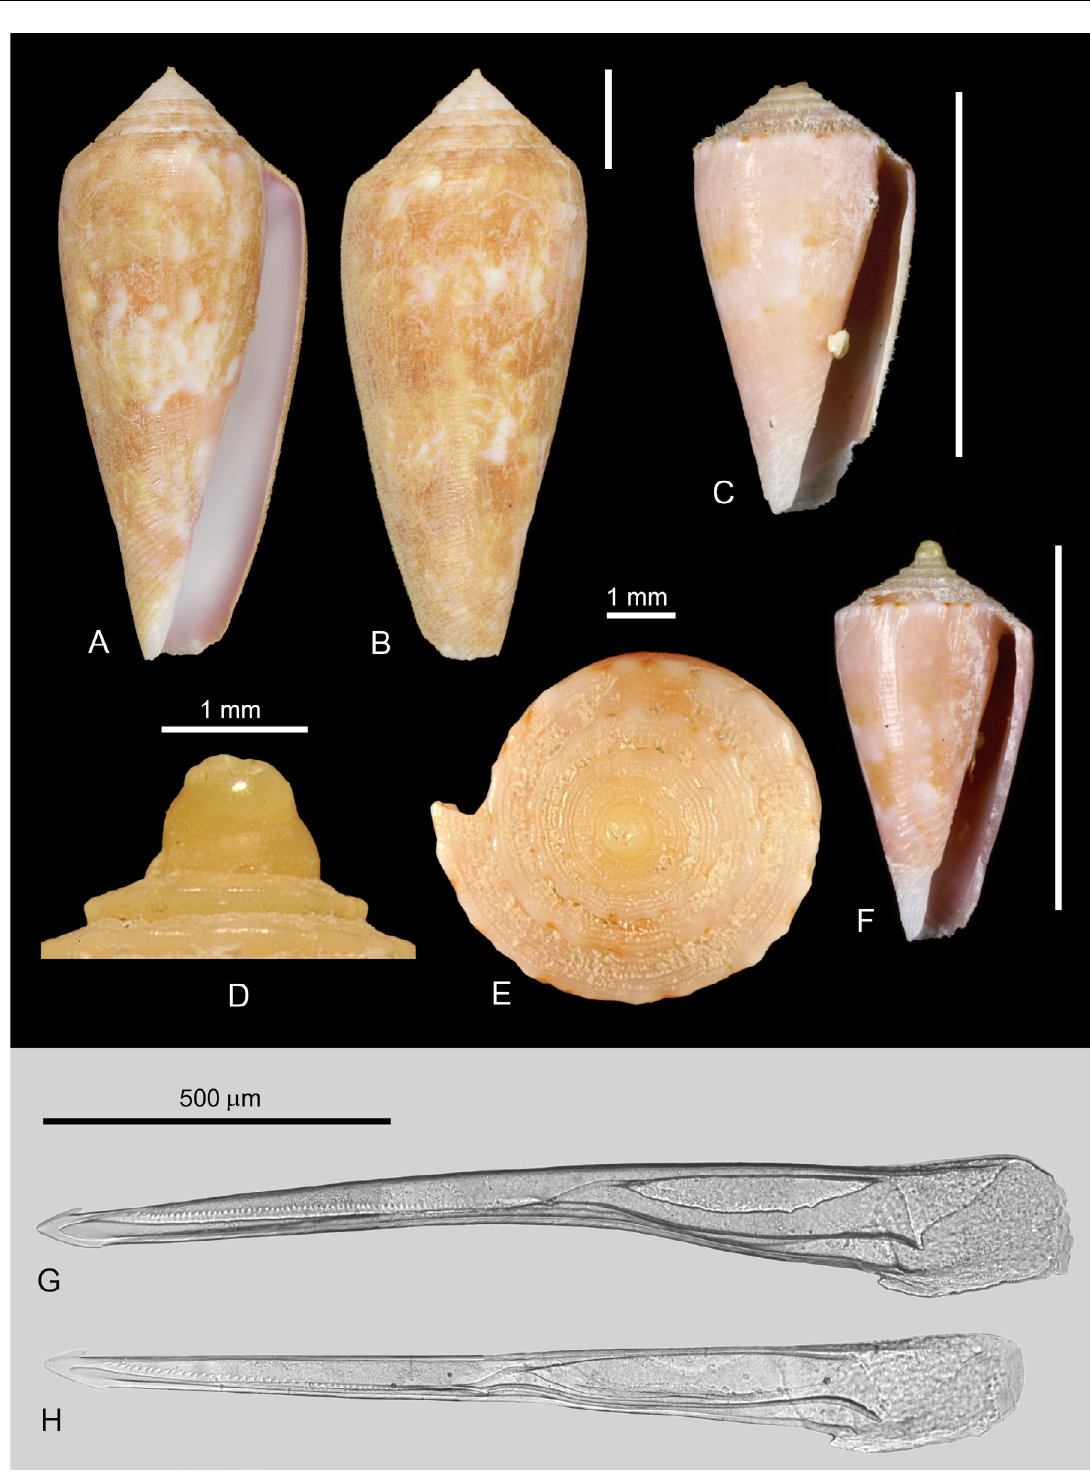
Fig. 4. Afonsoconus crosnieri sp. nov. A–B . Holotype, ventral and dorsal views, 59.6 × 24.8 mm (MNHN IM-2013-62927). C–G . Paratypes. C . Juvenile, 11.9 × 6.0 mm (MNHN IM-2013-62933). D–F . Juvenile, 11.5 × 5.7 mm (MNHN IM-2013-62932). D . Enlargement of the spire. E . Apical view of the spire. F . Shell. G–H . radular teeth. G . Specimen of 71.0 × 27.4 mm (MNHN IM-2013-62925). H . Holotype. Scale bars = 10 mm, unless otherwise